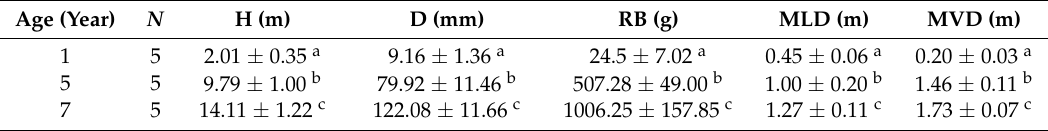
Table 2. General measurements of the excavated Salix alba L. ‘Tristis’ (LBS).